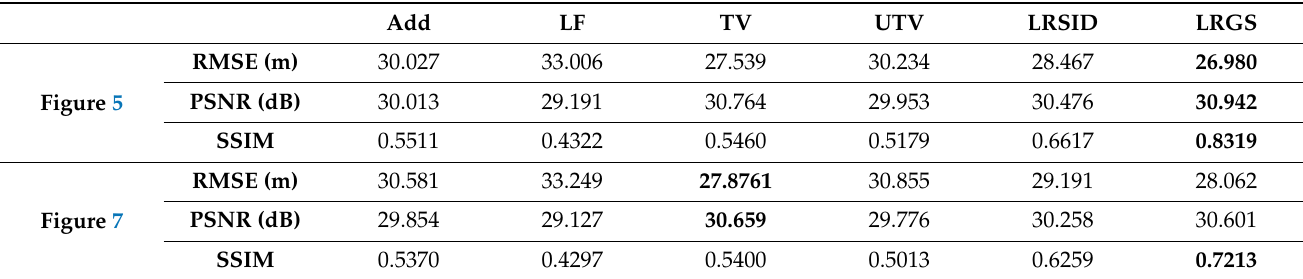
Figure 6. Local enlargement of the results of the simulation experiment for area N01E12 (Figure 5). Local enlargements for ( a ) area N01E12, ( b ) mixed error added, ( c ) low-pass filter, ( d ) TV, ( e ) UTV, ( f ) LRSID and ( g ) LRGS. Table 1. Results of the peak signal-to-noise ratio (PSNR) and structural similarity index (SSIM) simulation experiments.